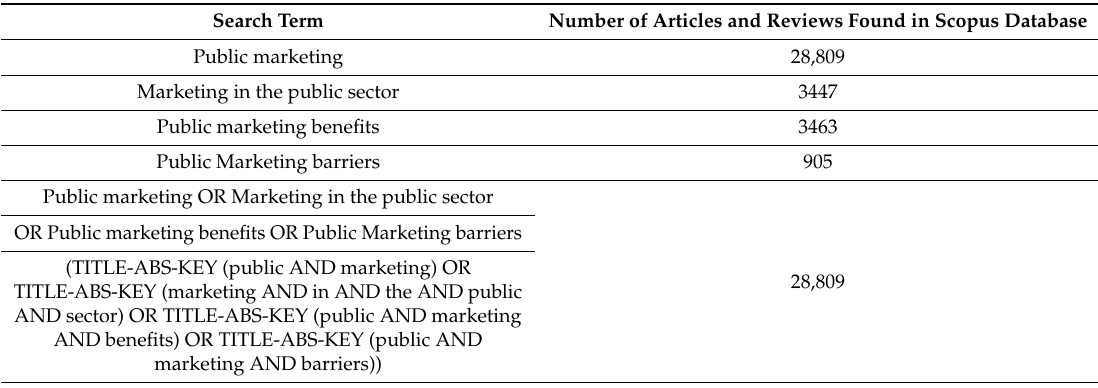
Table 1. Results of the search strings and number of articles found on Scopus